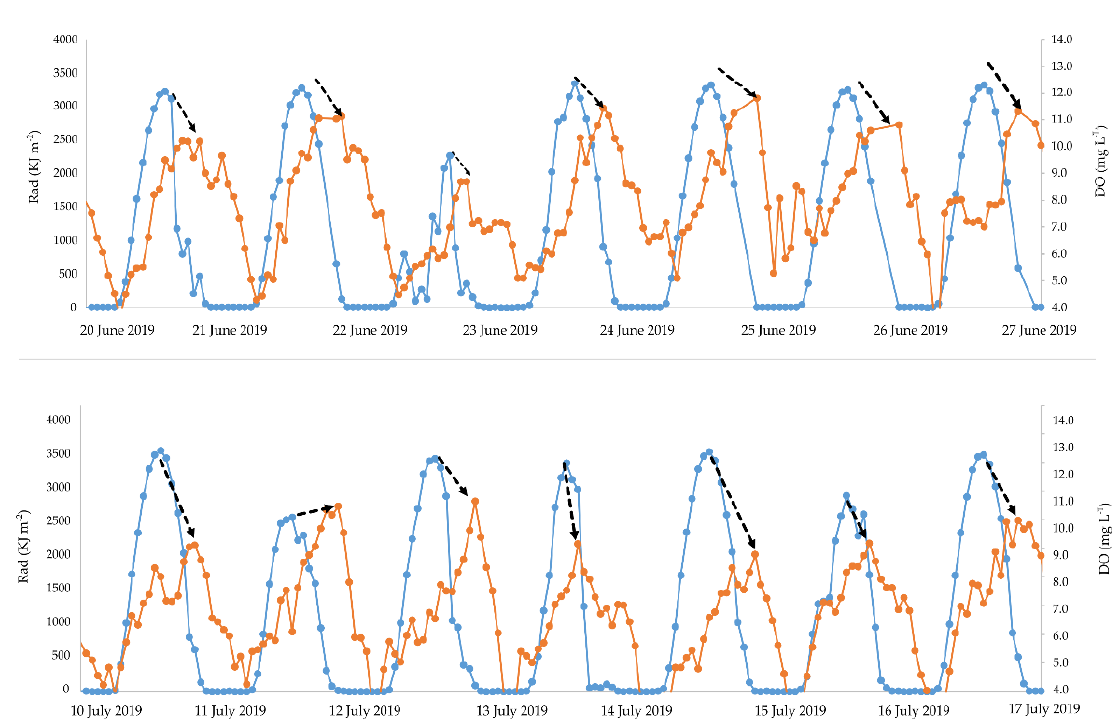
Figure 8. Time series of intensity of solar radiation (blue) plotted vs. DO (orange) at site M5 at June and July 2019 (see Table S4 in Supplementary Materials). In both cases is reported a sketch of one week. Arrows display the delay of DO peak with respect to the maximum intensity of solar radia- tion.